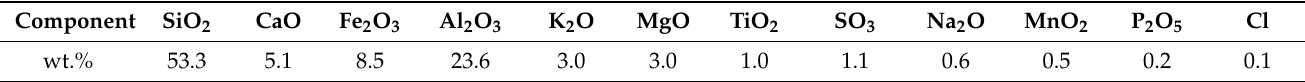
Table 2. Chemical Composition of Fly Ash in Weight.% Obtained by Energy-Dispersive X-ray Spectroscopy. Component wt.%